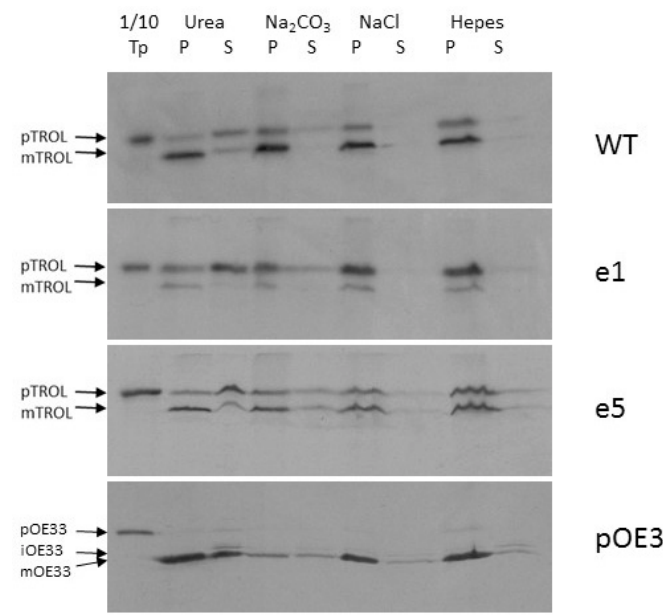
Figure 5. Extraction of wt TROL and its presequence mutants e1 and e5 from the membranes. In vitro synthesized [ 35 S]-TROL, e1, e5, and control protein pOE33 were incubated with isolated intact chloroplasts at 25 ° C for 20 min, in a standard import reaction containing 3 mM ATP. Subsequent to import, chloroplasts were re-isolated, washed, and separated into membrane and soluble fractions. Isolated membranes, containing imported proteins, were treated with 6 M Urea in 10 mM HEPES/KOH pH 7.6 (lanes 2 and 3), 0.1 M Na 2 CO 3 pH 11.5 (lanes 4 and 5), or 1 M NaCl (lanes 6 and 7). All incubations were performed for 20 min on RT. As a control, membranes were incubated solely in 10 mM HEPES/KOH pH 7.6 for 30 min on ice (lanes 8 and 9). Afterwards, samples were centrifuged at 265,000× g for 10 min at 4 °C, and both pellets (P, lanes 2, 4, 6, and 8) and the supernatants (S, lanes 3, 5, 7, and 9) were analyzed by SDS–PAGE and by exposure on X-ray films. Lane 1 represents 10% of the respective translation product (Tp) used for the import reactions. The positions of pTROL, mTROL, pOE33, iOE33, and mOE33 are indicated by arrows.